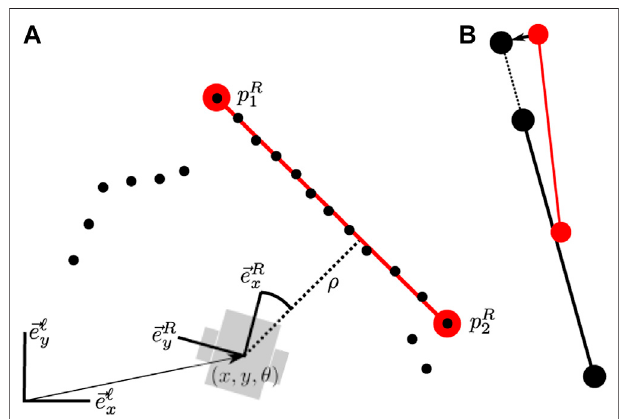
FIGURE 14 | (A) The robot measures a sensor feature locally in the form of a line segment. The line segment gets added to the local map and a range- bearing measurement is added as well. (B) When a new sensor feature is associated with the same line segment on the local map, it is merged to form updated end points. The new range bearing measurement is also added between the robot pose and the line (but not shown).